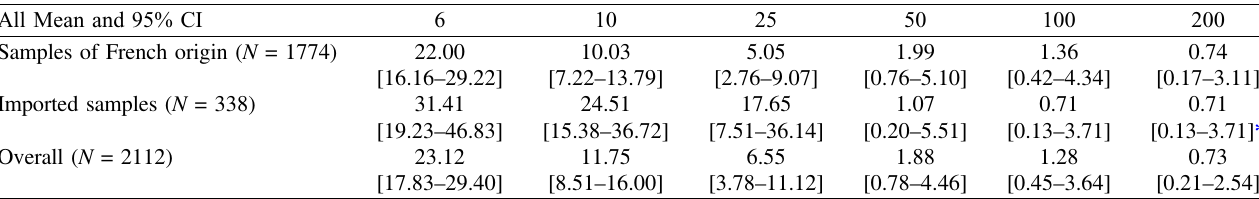
Table 4. The overall seroprevalence of Toxoplasma gondii infection in adults consumed in France accordingly to the terminal titer (6; 10; 25; 50; 100; 200).